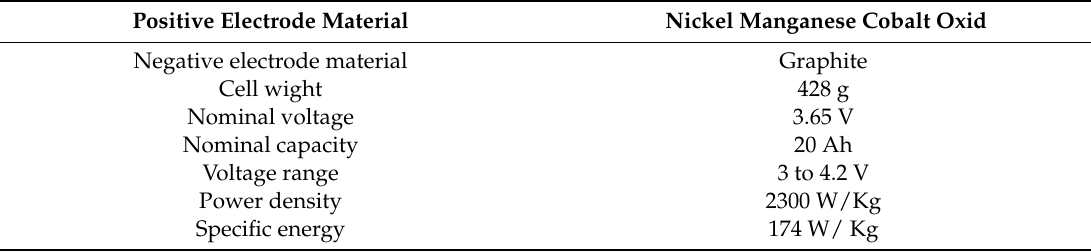
Table 1. Specifications of tested